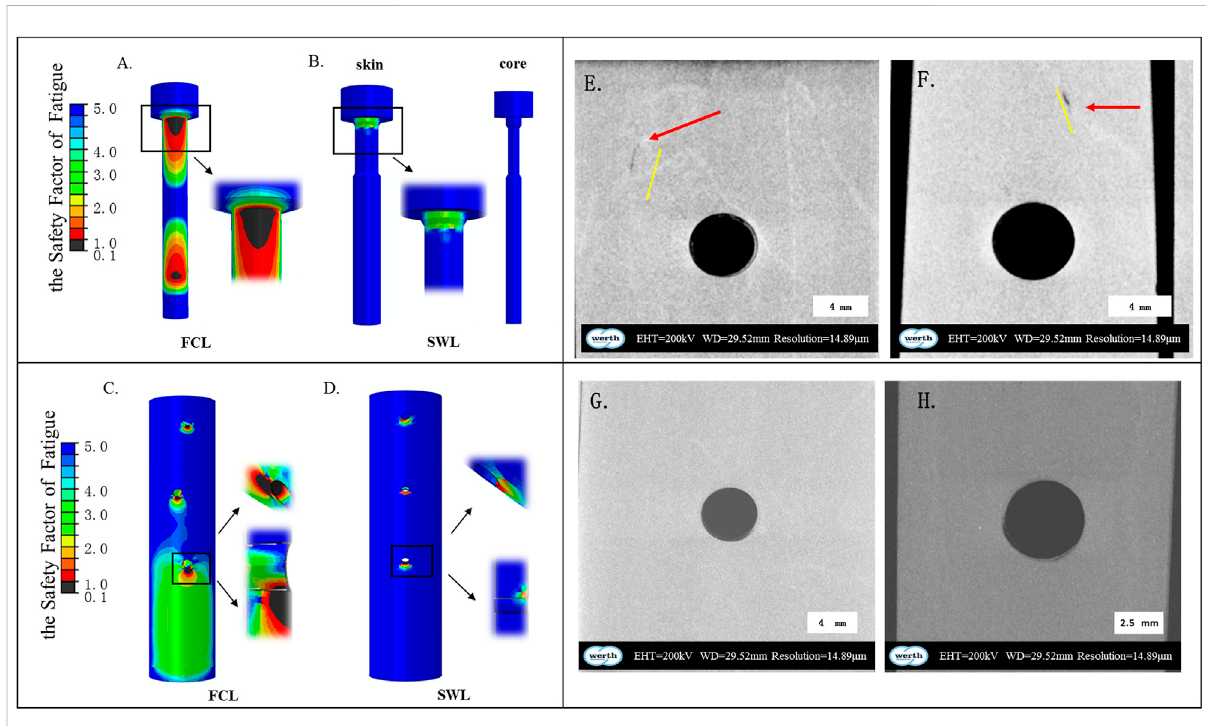
FIGURE 6 Numerical simulation and experimental results of high-cycle fatigue of three constructs. (A – D) High-cycle fatigue assessment and analysis basedonFE-safe,thedistributioncloudmapoffatiguesafetyfactors. (E – H) Theappearanceofcrackinitiationintheareaofscrew-boneinterfaceat the far cortices: FCL construct samples (E,F) , LP construct samples (G) , SWL construct samples (H) .